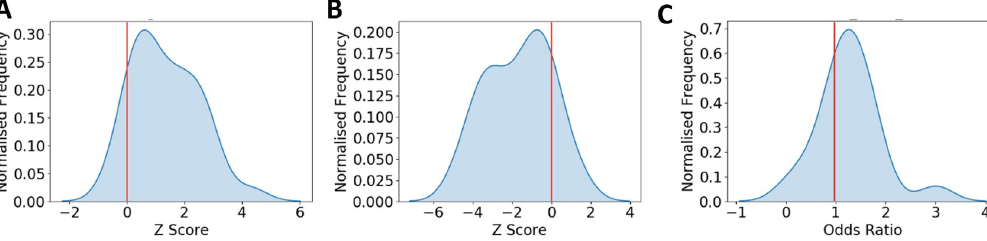
Fig 5. TRGs cluster both on the linear as well as in the 3D genome and are dysregulated in tissue specific cancer. (A) Z- score distribution for fraction of TRGs contained in clusters (size > = 5 TRGs) compared to a null distribution along the linear genome (top 5% TRGs considered; 5 or more genes in a cluster no more than 500kb apart) (B) Z-score distribution of number of TADs containing more than 5% of TRGs (C) Odds ratio distribution for TRGs enrichment in dysregulated genes in cancer types. Red line denotes the expected